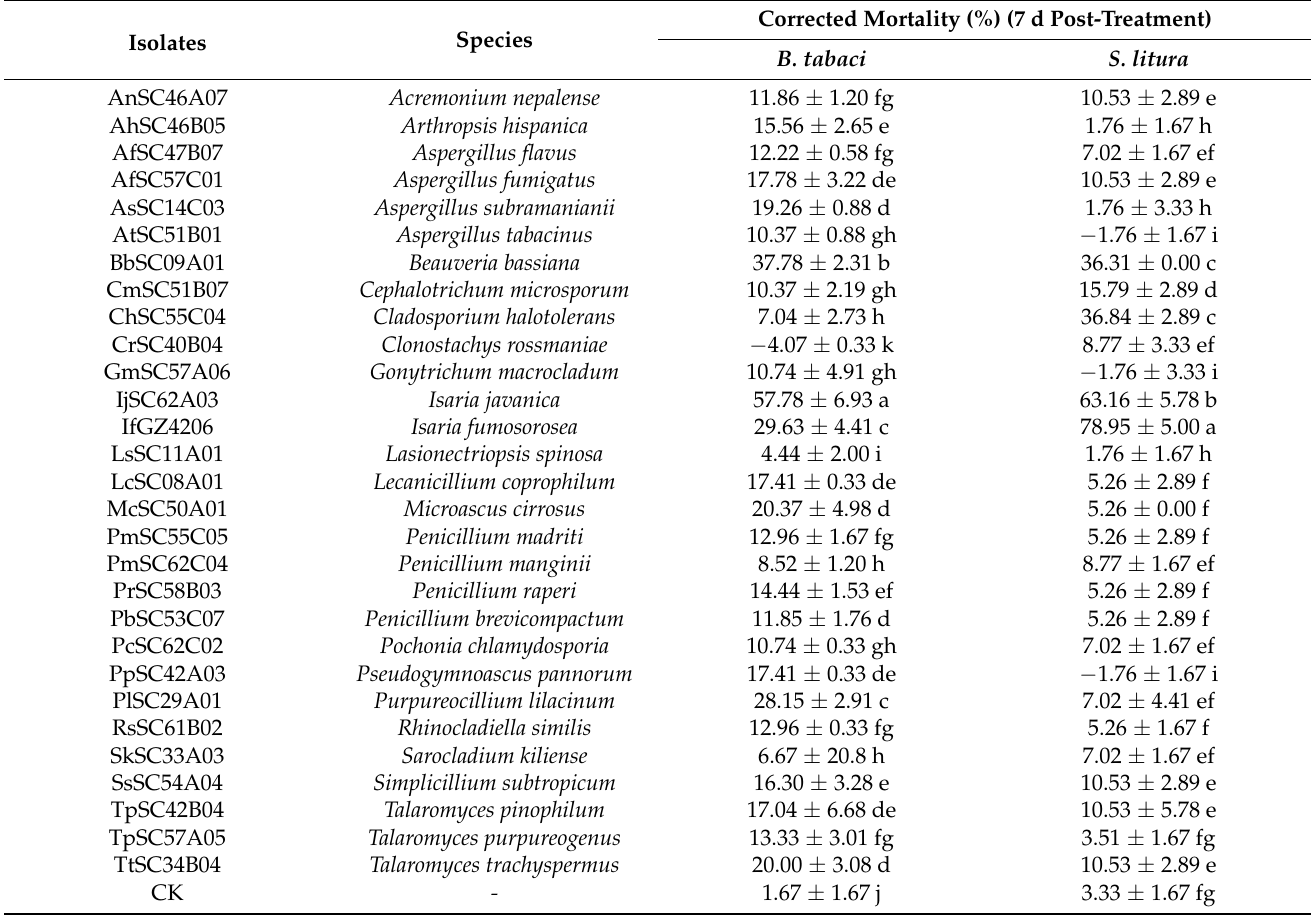
Table 4. The pathogenicity of fungal isolates against B. tabaci and S. litura . Isolates